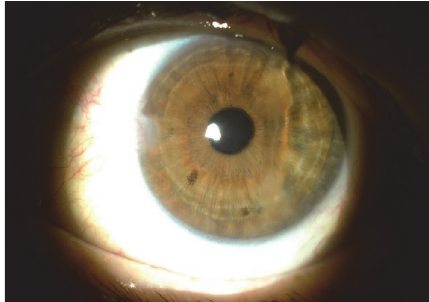
Figure 2: Inferior keratitis.